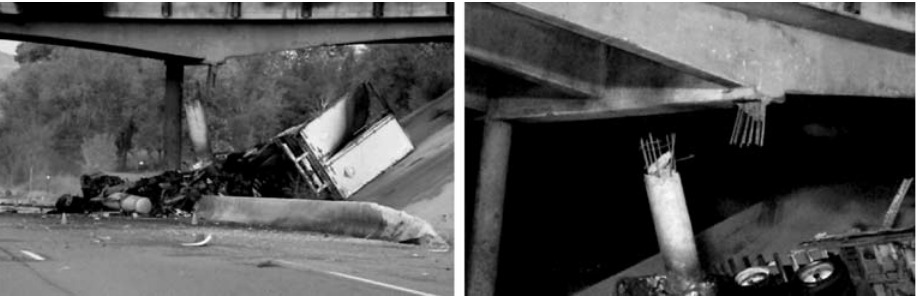
fig. 7. The Road 26.5 bridge in Grand Junction (Colorado, US) lost a support column and was closed after it was hit by a semi-truck on August 15,